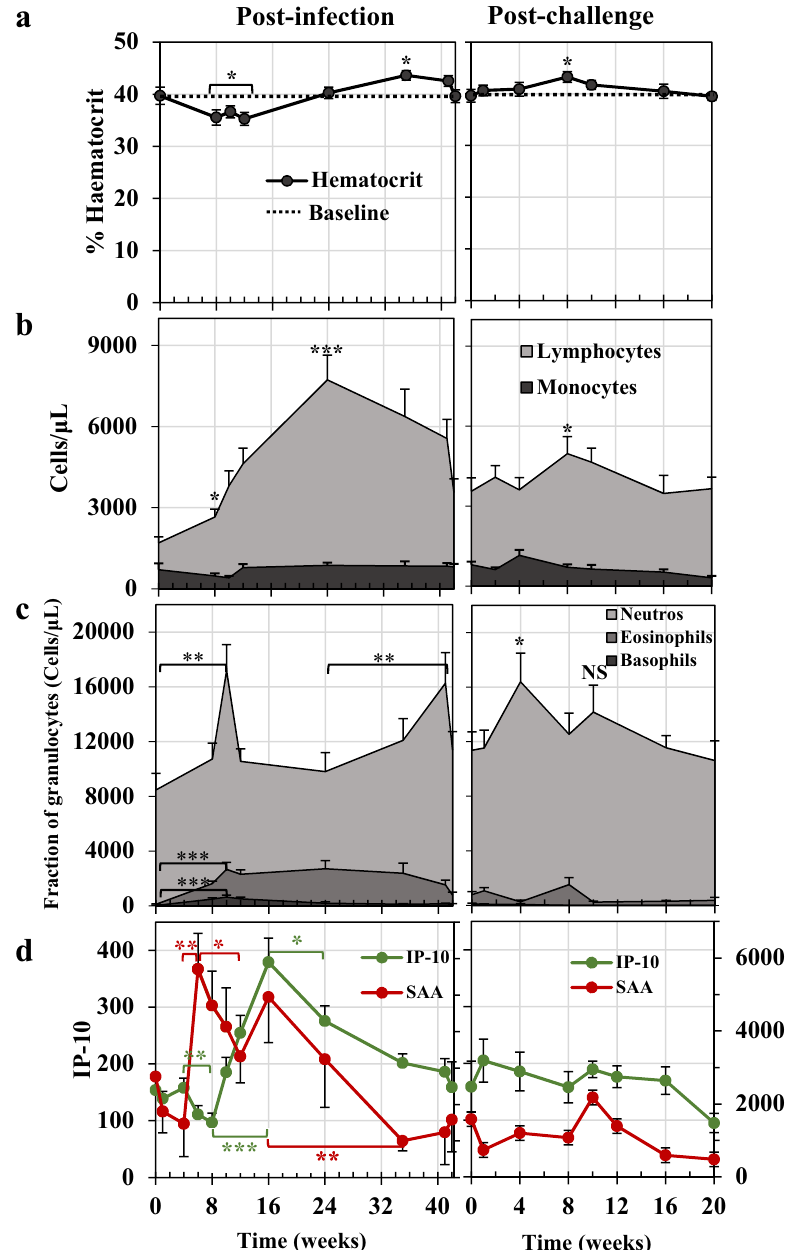
Fig. 6 Haematology and in fl ammatory markers over the primary infection and secondary challenge. a Mean haematocrit values for rhesus macaques. The baselines at Week 0 and again at Week 0 post-challenge are plotted as dotted lines to illustrate variations from the norm. Statistical comparisons using one-sided Student ’ s t -test are with that norm, where signi fi cance P < 0.05 *. b Lymphocytes and monocytes plotted as absolute numbers per microlitre of blood. c Neutrophils, eosinophils and basophils plotted as proportions of the total polymorphonuclear population per microlitre of blood. Statistical comparisons using one-sided Student ’ s t -test in b and c are with the values at Week 0 post-infection and the Week 42 challenge point, respectively, to show fl uctuations from the steady-state induced by either the primary infection or the secondary challenge, respectively. Signi fi cances are P < 0.05 *, <0.01**, <0.001***. NS, not signi fi cant. d Fluctuations in the circulating level of the two markers of in fl ammation, interferon-gamma inducing factor 10 (IP-10/CXCL10, green line) and serum amyloid A (SAA, red line). Values are means ± SE. Statistical comparisons made using one-sided Student ’ s t -test are indicated with brackets, and signi fi cances shown as P < 0.05 *, <0.01**, <0.001***; n = 11 rhesus macaques, excluding Rh10. Source data are provided as a Source Data fi in either SAA or IP-10 over the fi rst 4 weeks (Fig. 6d). The level of infection, with wide variation between animals (Wk8pc mean SAA then increased 3.9-fold, from Wk4 to a peak at Wk6, NS versus Wk42/Wk0pc), while basophils did not feature at all. coincident with the onset of egg deposition ( P < 0.01), followed by a slower decline out to Wk12 ( P < 0.05). The apparent increase The in fl ammatory markers SAA and IP-10 show reciprocal between Wk12 and Wk16 was not signi fi cant, but SAA then fell patterns of activity . There was no statistically signi fi cant change gradually to the background level by Wk32 ( P < 0.01). After the